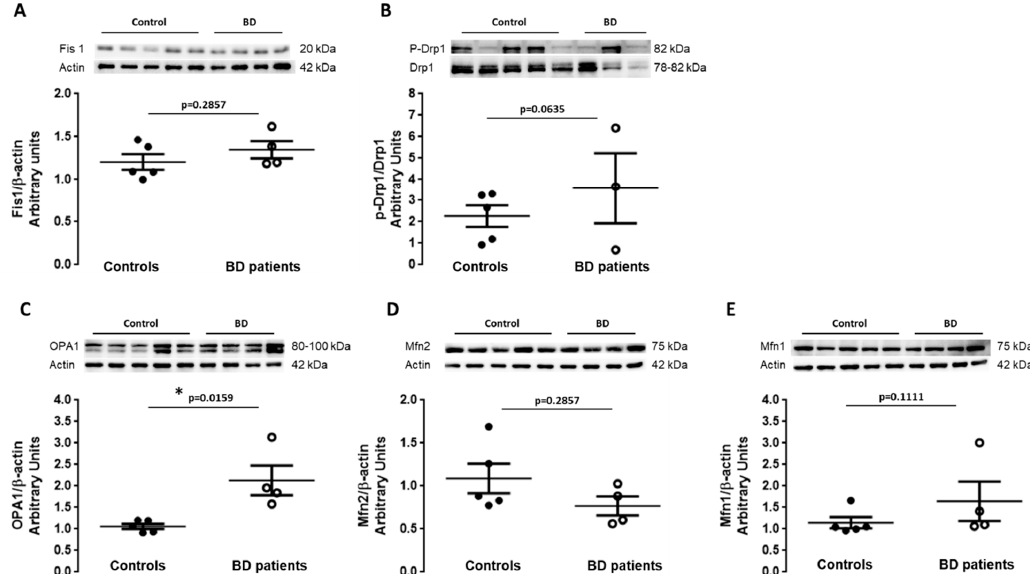
Figure 2. Fission/fusion machinery in BD patients’ fibroblasts. The levels of the mitochondrial fission proteins ( A ) Fis1 and ( B ) p-Drp1 and the mitochondrial fusion proteins ( C ) OPA1 ( D ) Mfn2 and ( E ) Mfn1, in fibroblasts from BD patients and control individuals were evaluated by Western blot analysis. Drp1 was used as the loading control for p-Drp1 (S616) and β -actin was used as loading control for the other proteins. The results were normalized to β -actin or Drp1 and expressed as mean ± SEM of 5 different control individuals and 3-4 BD patients. WB representative images correspond to BD and control samples analyzed on the same gel. * p < 0.05, significantly different from control group, as determined by Mann–Whitney non-parametric test.